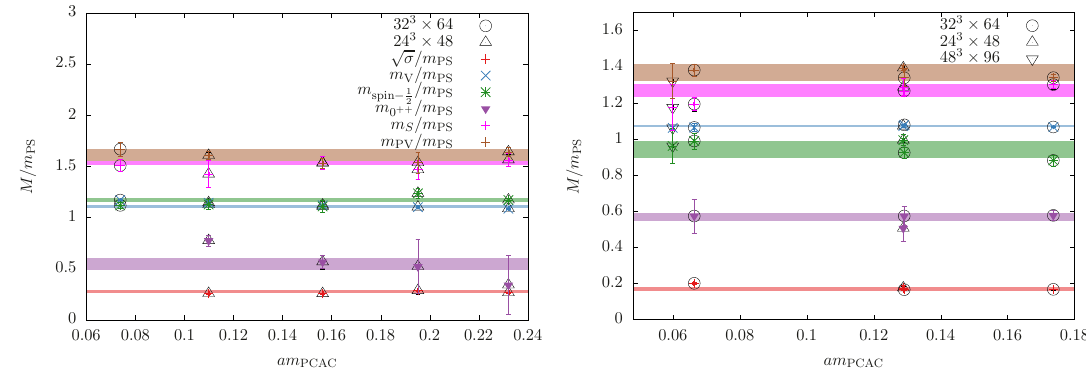
p (cid:27) in units of the pseudoscalar mass as a function of am